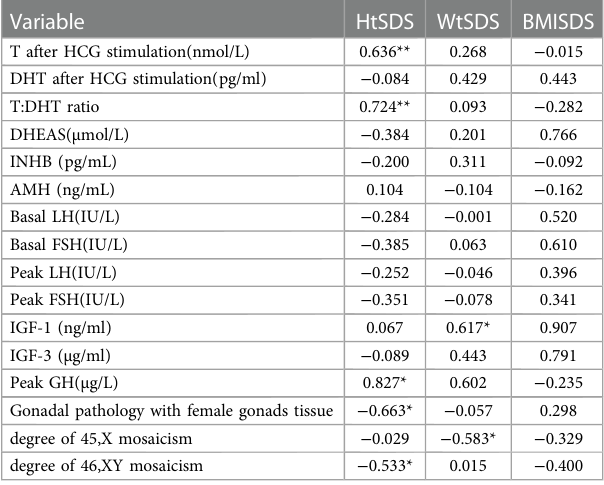
TABLE 5 Correlation between height, weight, BMI and various indicators in 45,X/46,XY children. Variable